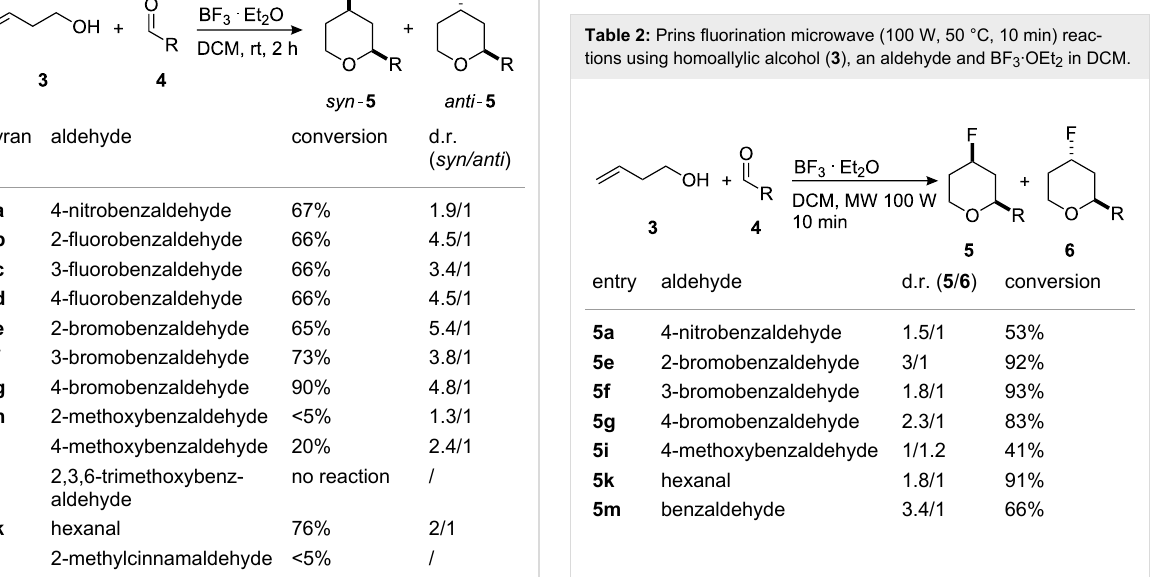
Table 2: Prins fluorination microwave (100 W, 50 °C, 10 min) reac- tions using homoallylic alcohol ( 3 ), an aldehyde and BF 3 ·OEt 2 in